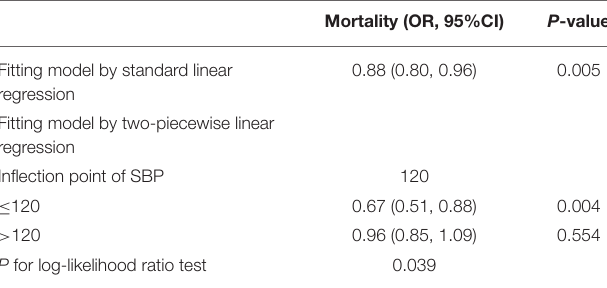
TABLE 4 | The results of the two-piecewise linear model (SBP per 10